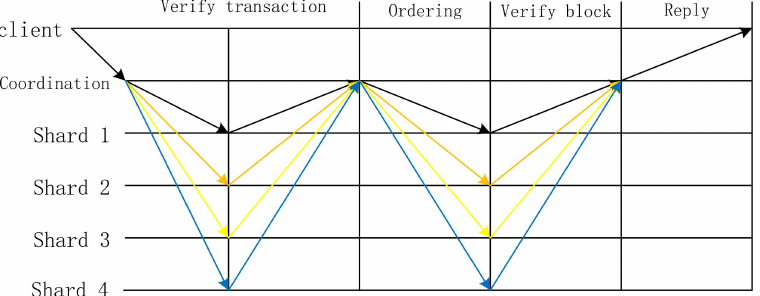
Figure 5. ST-PBFT consensus process.